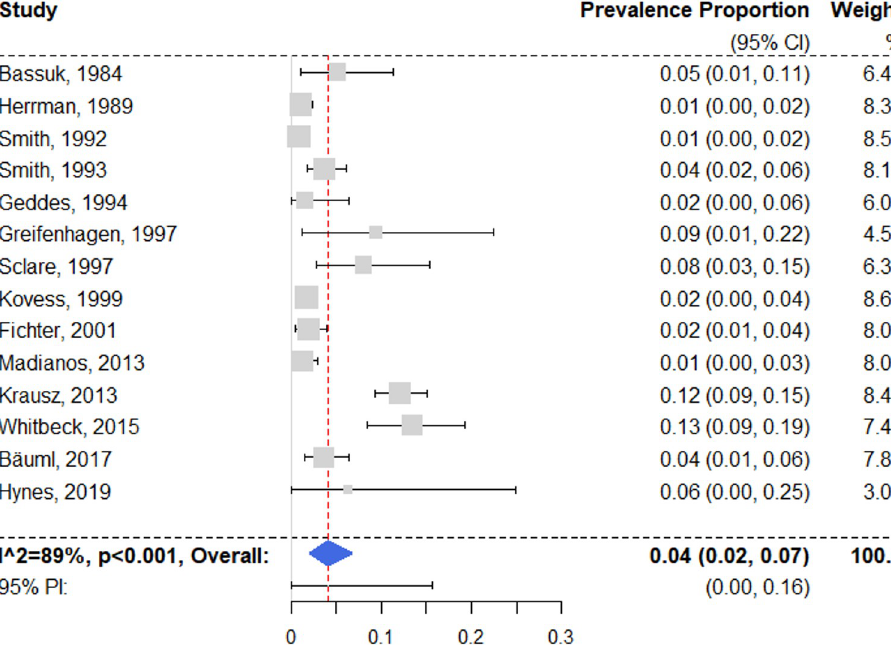
Fig 5. Forest plot of prevalence estimates of bipolar disorder. AU : Basedonthereferenceslist ; IbelievethefollowingareerrorsinFig 5 : ð 1 Þ Newton ; 1994 shouldbeGeddes ; 1994 ½ 67 �ð 2 Þ Hynes ; 2018 shouldbeHynes ; 2019 ½ 62 � PleasefixtheseerrorsinFig 5 : Asecond (cid:0) bestsolutionwouldbetoequatethesemisidentifiedrefswiththeircorrectreferencenumbersinthefigurelegend : Analytic weights are from random effects meta- analysis. Grey boxes represent study estimates; their size is proportional to the respective analytical weight. Lines through the boxes represent the 95% CIs around the study estimates. The blue diamond represents the mean estimate and its 95% CI. The vertical red dashed line indicates the mean estimate. CI, confidence interval; PI, prediction interval; RE, random